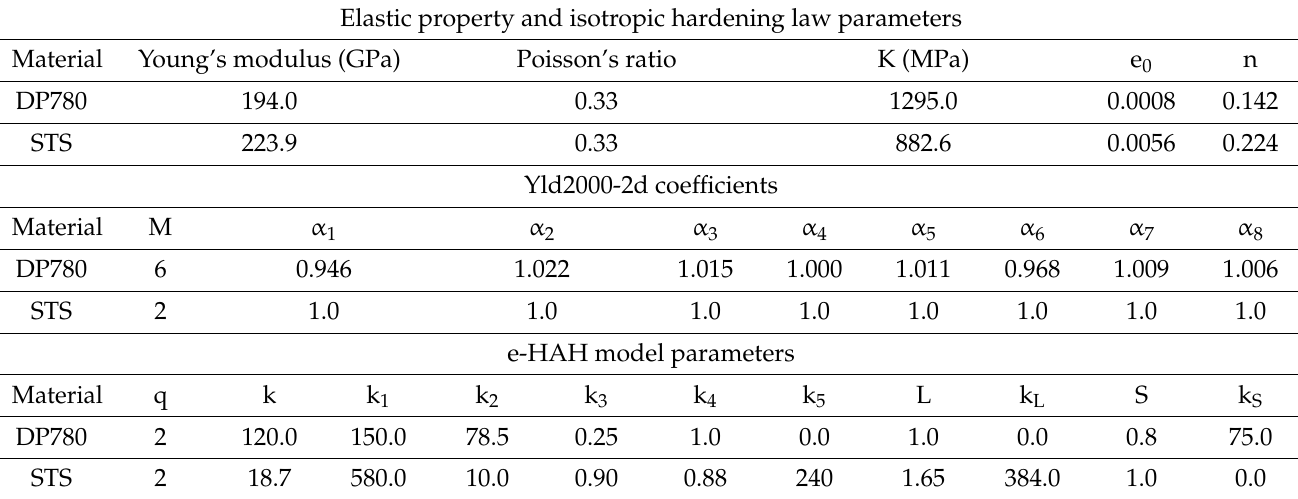
Table 7. Material properties and model parameters of DP780 [41] and STS [64] for e-HAH. Elastic property and isotropic hardening law